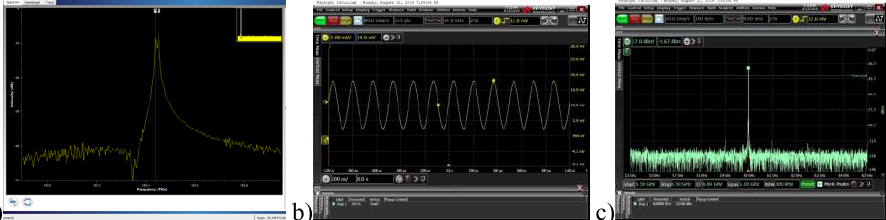
Fig. 8. Spectral density of the selected modes registered with an optical spectrum analyzer (a), and difference mode oscilloscope signal (b) and spectral density